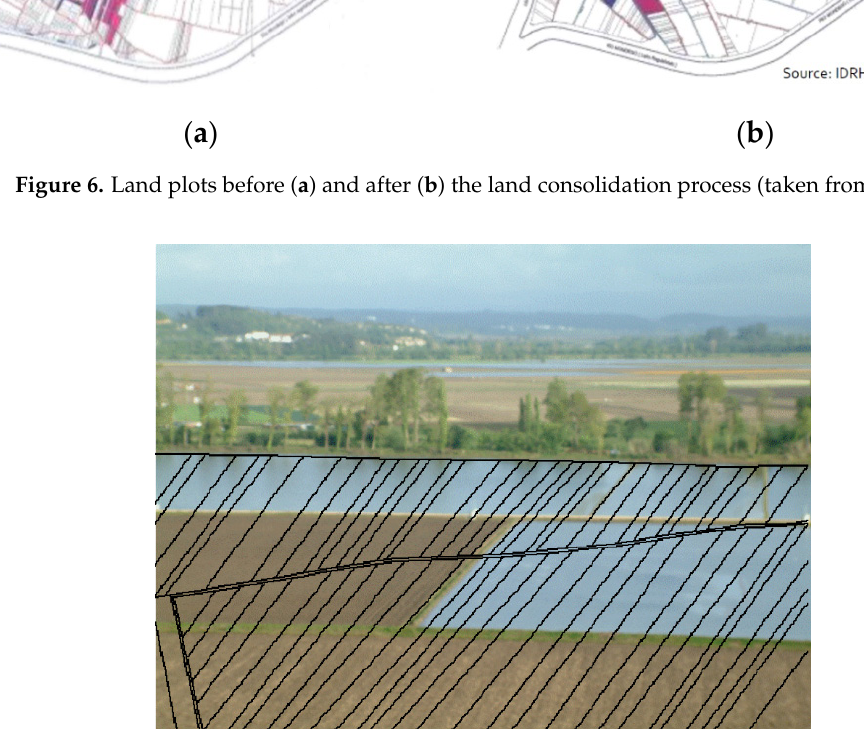
Figure 7. Plot sizes before (black lines) and after the land consolidation process (extracted from [39]).